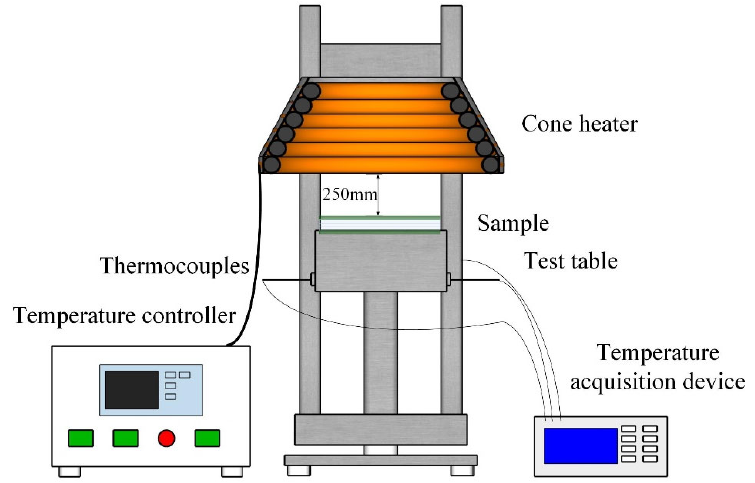
Figure 2. Schematic diagram of heat insulation